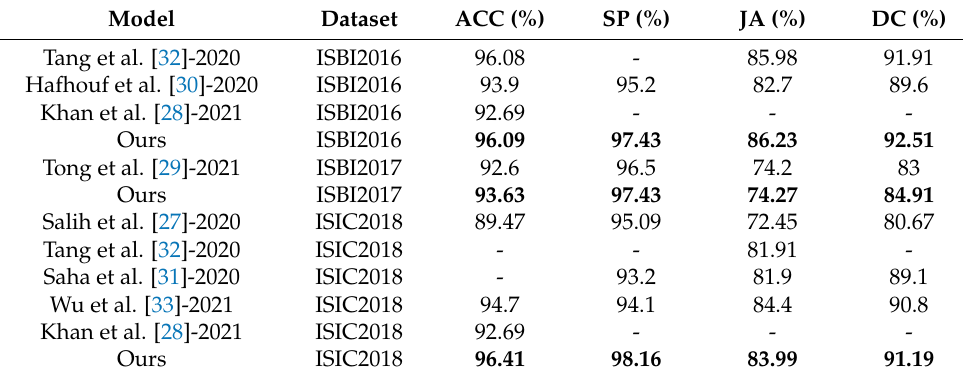
Table 7. Comparisons with State-of-the-Art